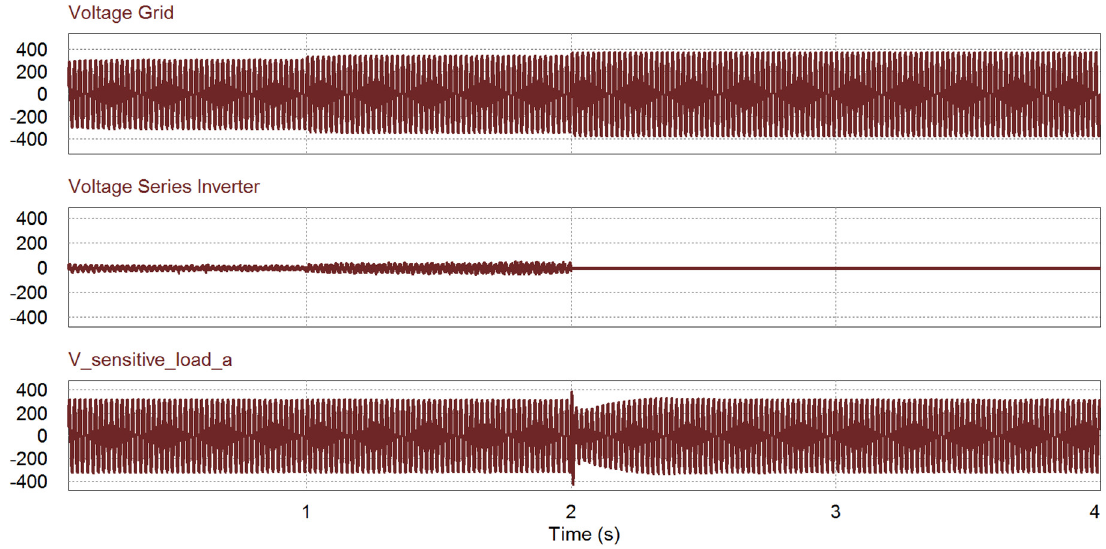
Figure 15. Simulation results of overvoltage case: ( top ) Grid voltage; ( middle ) series inverter voltage; ( bottom ) sensitive load voltage.